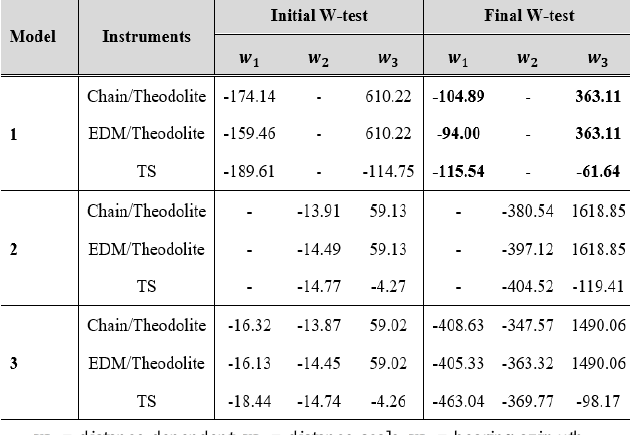
= distance-dependent; = distance-scale; = bearing azimuth Table 5. Results of W-test for Dataset 2 using